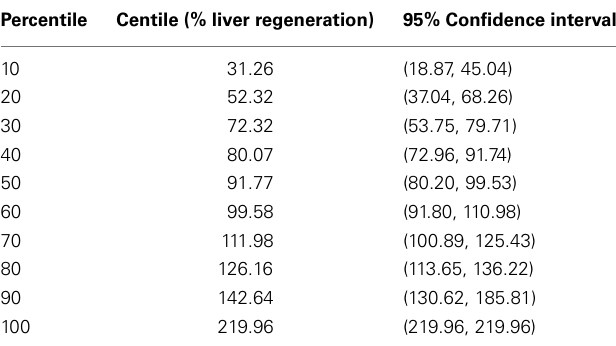
Table 2 | Descriptive percentile distribution of percentage liver regeneration for all